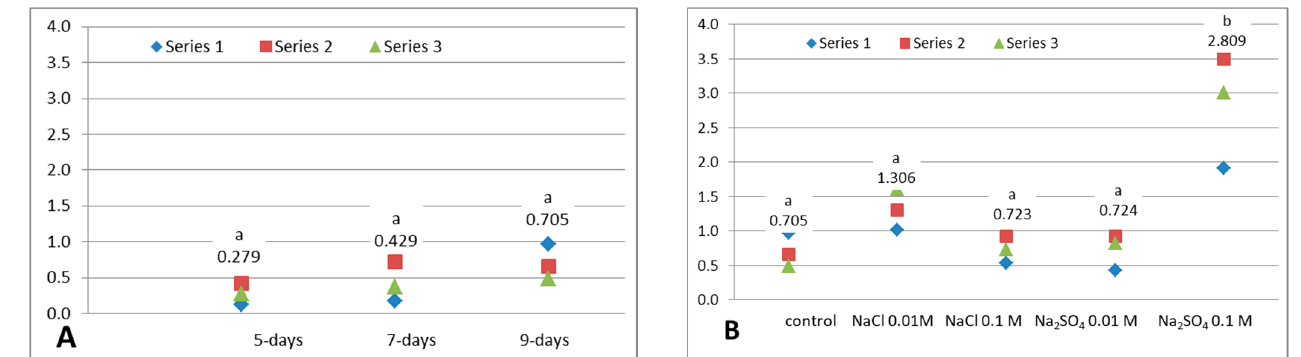
Figure 2. Total anthocyanins content (TAC) of white cabbage microgreens. ( A ). Influence of growth: untreated 5-, 7- and 9-day-old microgreens ( α = 0.05, between groups df = 2, F = 2.721, p = 0.144). ( B ). Influence of NaCl or Na 2 SO 4 treatments on 9-day-old microgreens ( α = 0.05, between groups df = 4, F = 13.586, p = 0.000). Above the data points are displayed the mean values and a letter: different letters denote significant differences between values (Tukey HSD test). Series 1, 2 or 3 from the legend represent the 3 individual